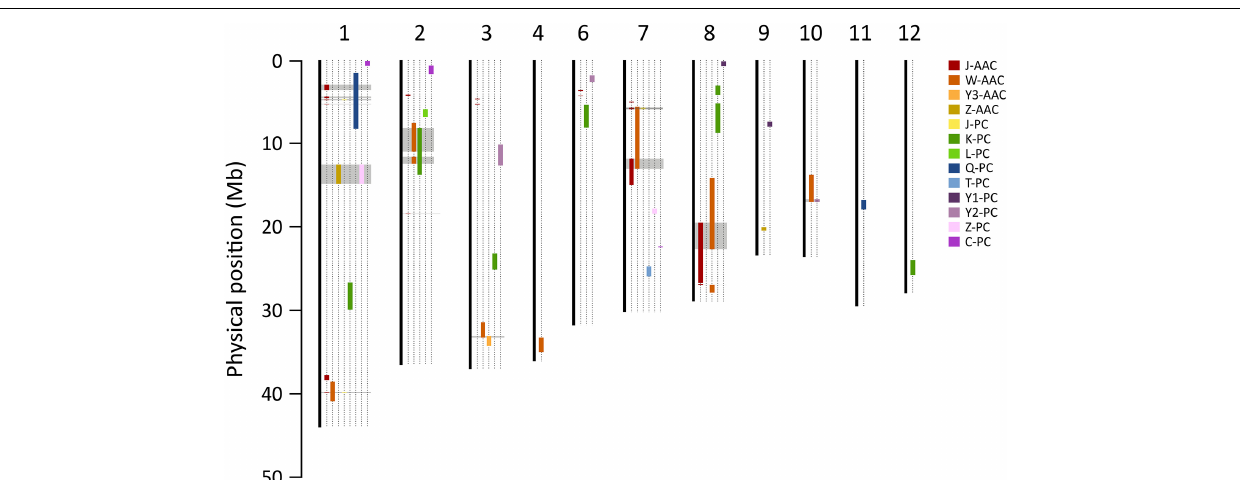
FIGURE 5 | Validation of qAAC7.1 effect. (A) Genetic background of M23- qAAC7.1 T887 . Red and green bar indicate the homozygous alleles from T887 and M23 allele, respectively. The gray bars indicate the heterozygous allele. (B) Allelic effect of qAAC7.1 T887 for AACs and PC. Different letters indicate significant differences between groups ( p ≤ 0.05, Tukey’s HSD test).